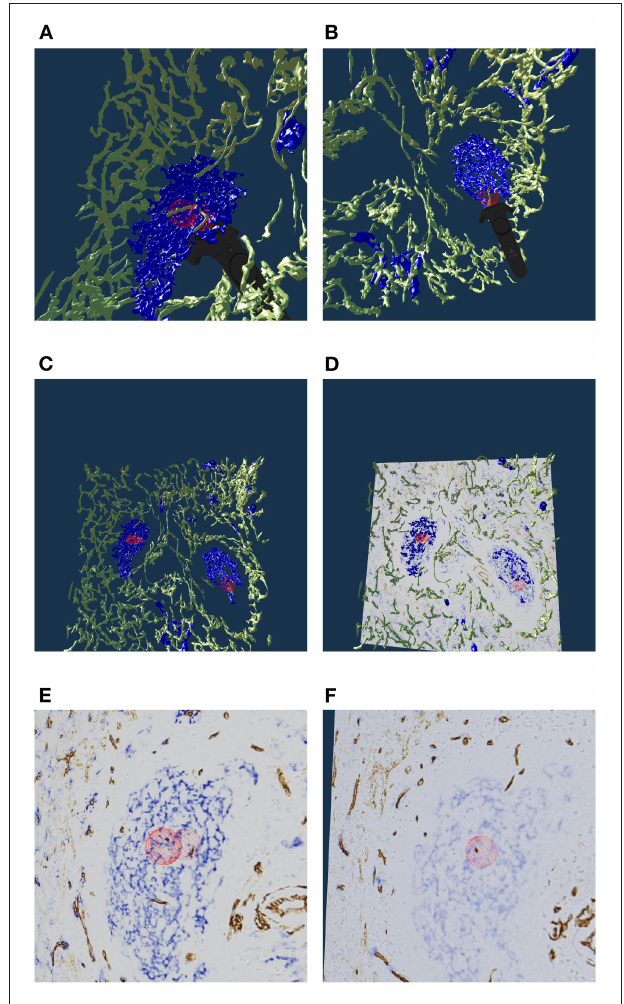
FIGURE 7 | Real or artifact? The models are derived from human spleen sections from the “follicle-double” data set. These sections were stained for CD34 (brown in staining, yellow in the reconstruction) and for CD271 (blue). In VR we spotted and annotated putative capillaries inside follicles (large blue structures, A,B ). We can look at the meshes only (C) or also show the original data (D) . A closer view (E,F) confirms: the reconstruction is correct, these structures are CD34 + objects inside the follicle. As the structures in question continue through multiple sections, they do not represent single CD34 + cells. Hence the objects in question must be blood vessels. The reconstruction is correct, the brown structures are real. All images in this figure are screenshots from our application. Similar results can be found in Steiniger et al.